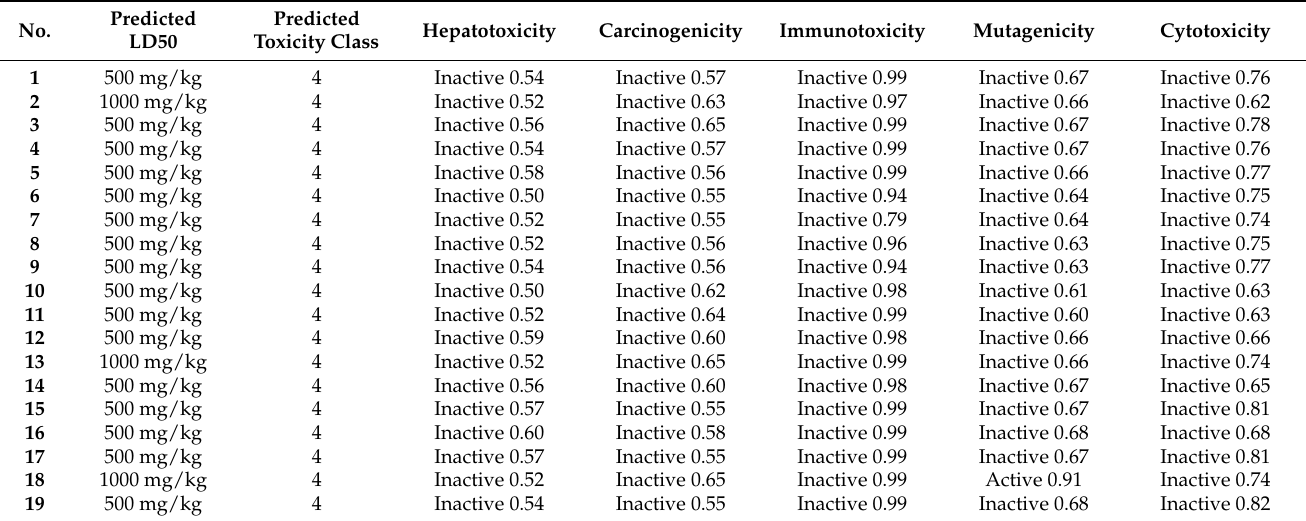
Table 1. Predicted toxicity with program PROTOX.